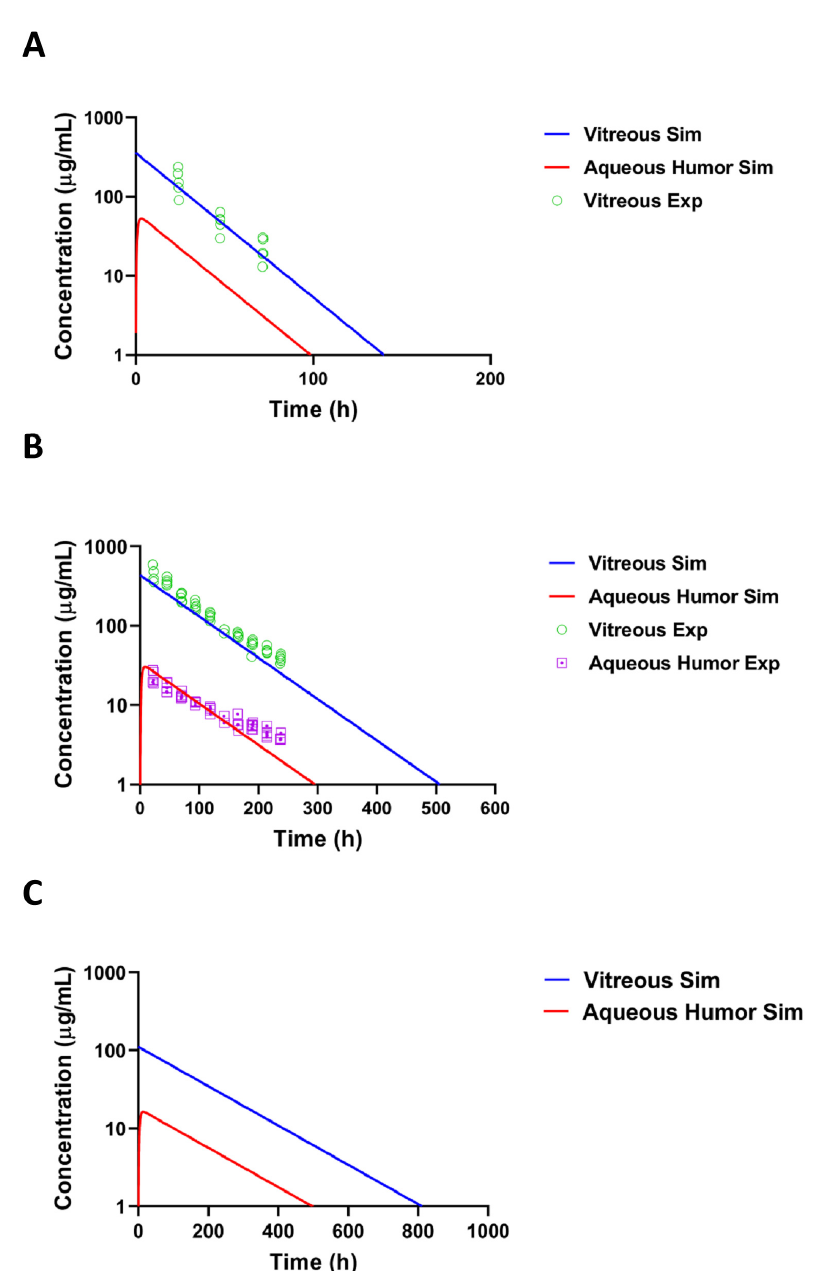
Figure 6. Simulated and experimental concentrations of BDP-pullulan-DEX in ( A ) rat, ( B ) rabbit and ( C ) human. The blue and red line shows the simulated concentration in vitreous and aqueous humor, respectively. The experimental concentrations in the vitreous and aqueous humor are indicated in the